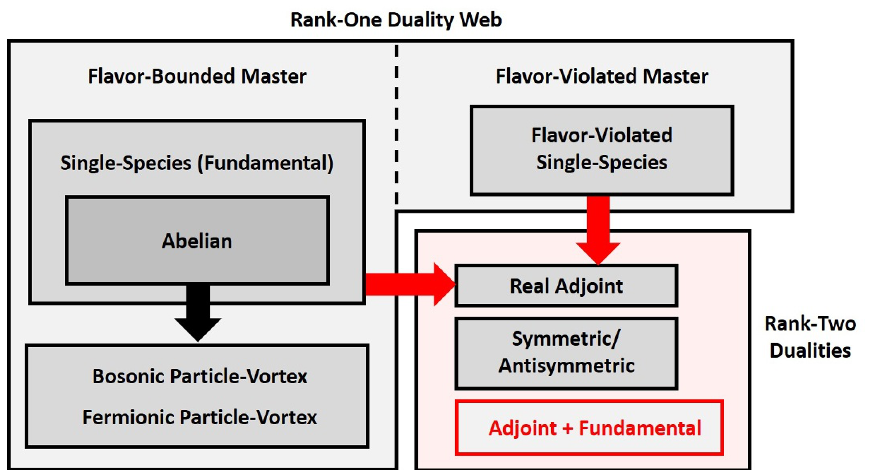
Figure 1 . Web of bosonization dualities in 2 + 1-dimensions. The contributions of this work are shaded in red. Speci(cid:12)cally, we show that the rank-two adjoint matter dualities can be connected to the rest of the web of dualities (red arrows). We also conjecture several new rank-two dualities including a duality with both fundamental and adjoint representation